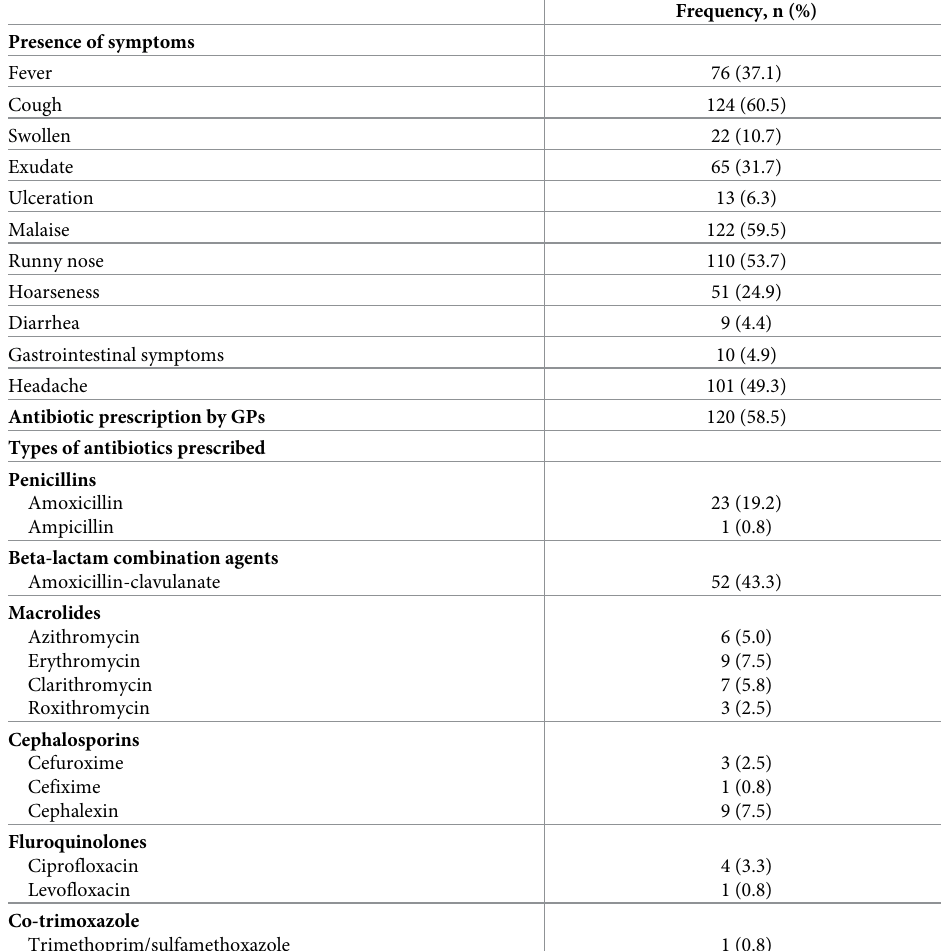
Table 3. Sore throat symptoms and antibiotic prescription by